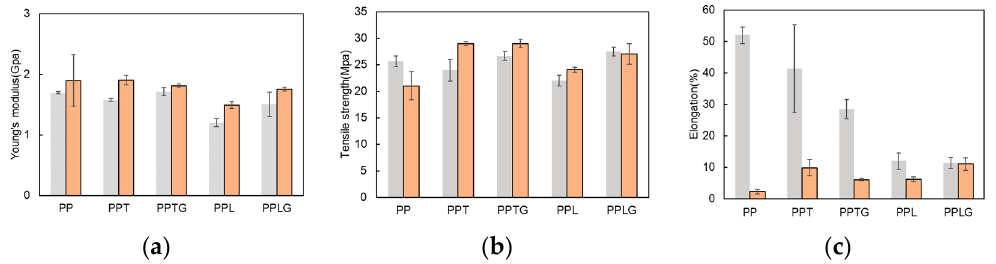
Figure 11. Young’s modulus, tensile strength, and elongation of PP and PP/polyphenol blends after weathering: ( a ) Young’s modulus; ( b ) Tensile strength; ( c ) Elongation. Grey-before weathering; orange-168 h UV weathering